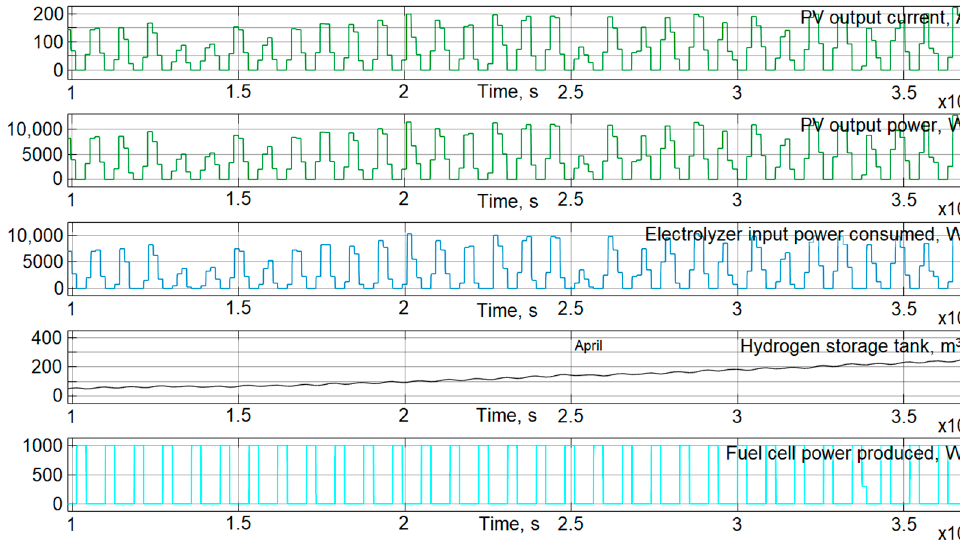
Figure 18. The result of the simulation and calculation of the required hydrogen tank capacity for the location Chelyabinsk, Russia (April only).